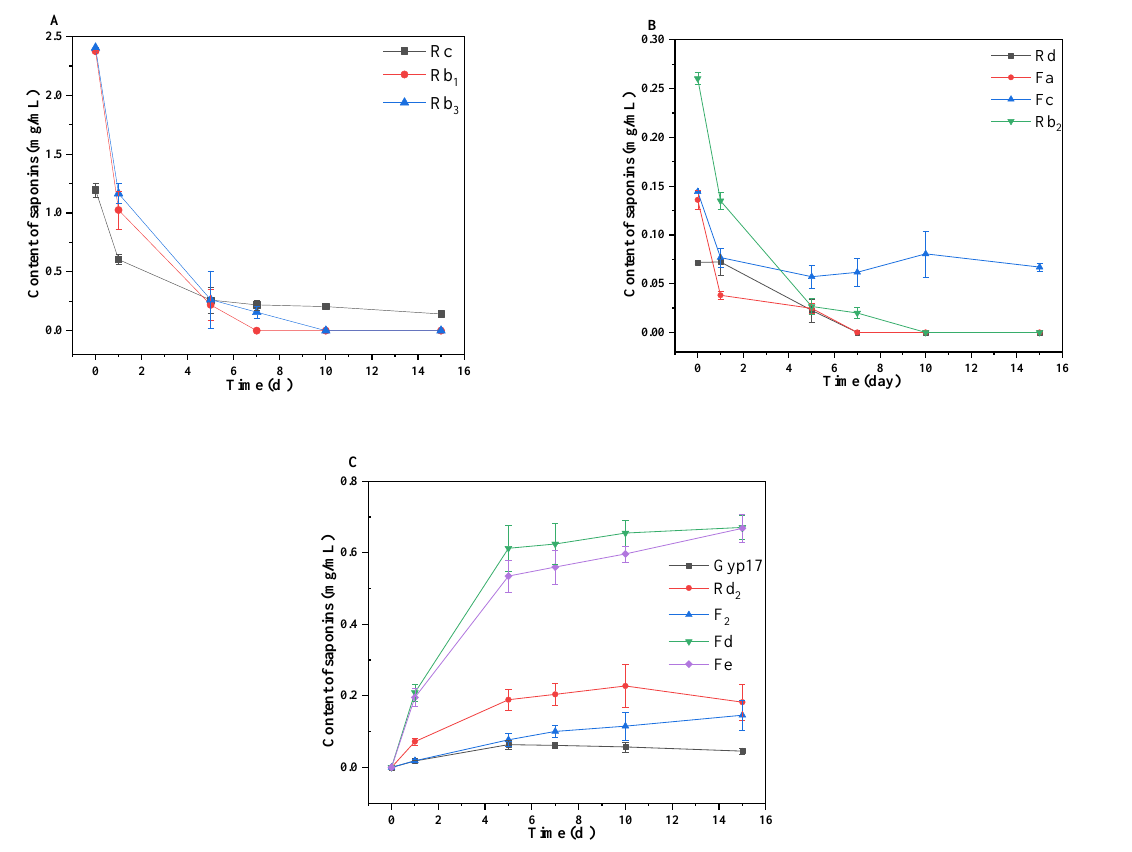
Figure 3. Dynamic change of substracts and products ginsenoside contents during biotransformation process by C. xylophilum . ( A ) Substracts (monomer ginsenosides Rc, Rb 1 , Rb 3 ) contents; ( B ) substracts (monomer ginsenosides Rd, Rb 2 , notoginsenosides Fa, Fc) contents; ( C ) converted products of ginsenoside F 2 , Rd 2 , notoginsenoside Fd, Fe, and Gyp 17.